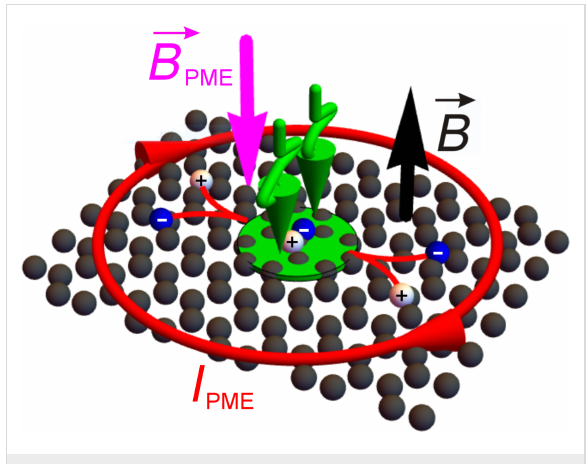
Figure 1: A schematic of the magnetic moment evoked by the PME circulating current in a point-illuminated 2D semiconductor in Corbino configuration ( – vector of external magnetic field induction; the green wavey arrow represents illumination; the green, partially transparent circle shows the illuminated area of the sample; the plus and minus signs represent the photogenerated electrons and holes separated by the magnetic field; I PME – the circulating PME